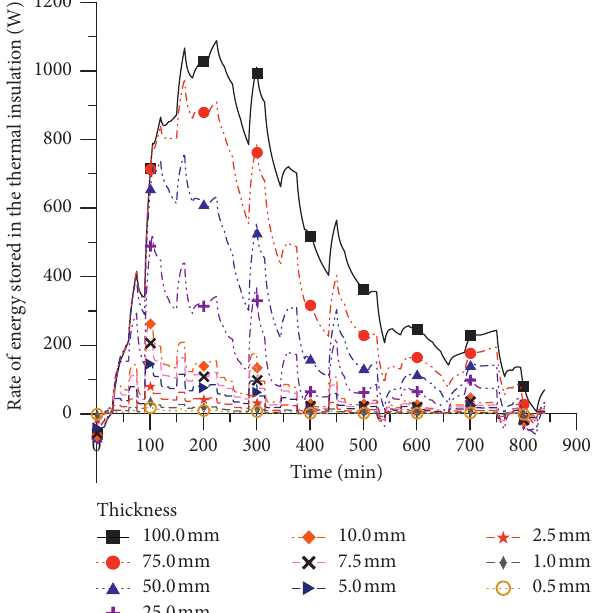
Figure 12: Rate at which energy is stored in the thermal insulation during the heating process for different ceramic fiber thicknesses.